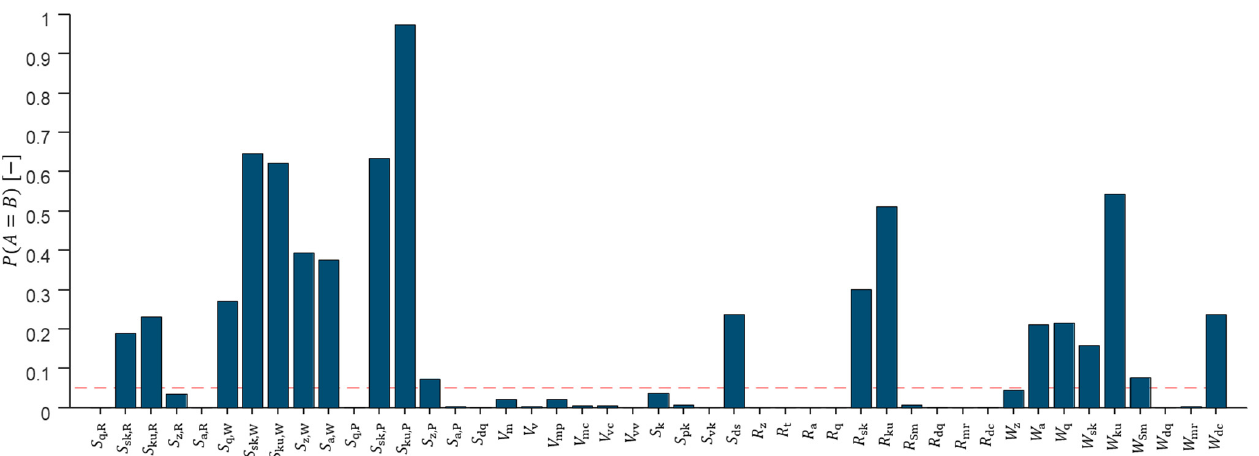
Figure 9. Result of the Wilcoxon rank-sum test for the investigation of the probability of equal sets A and B.